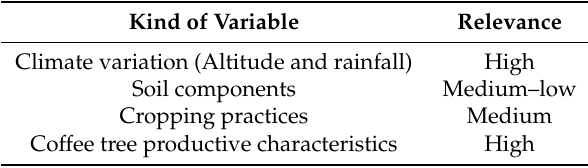
Table 1. Kinds of variables that describe the importance of coffee plots in the presence of CLR